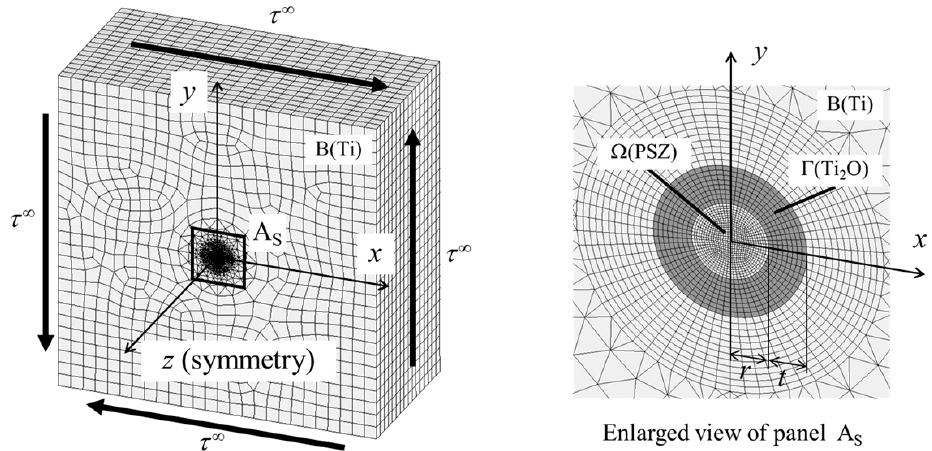
Figure A1. Finite element analysis of double inclusion subjected to shear loading.